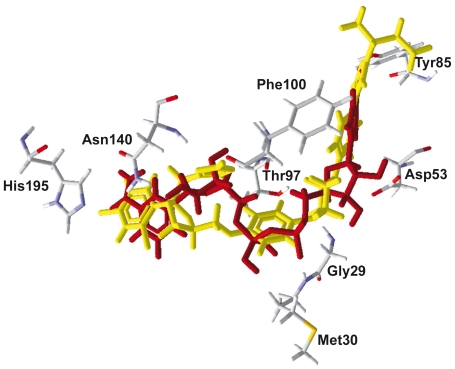
Superposition of the best conformation of itraconazole (in yellow) and NADH (in red) in the active site pocket of P. falciparum enzyme lactate dehydrogenase (PfLDH).